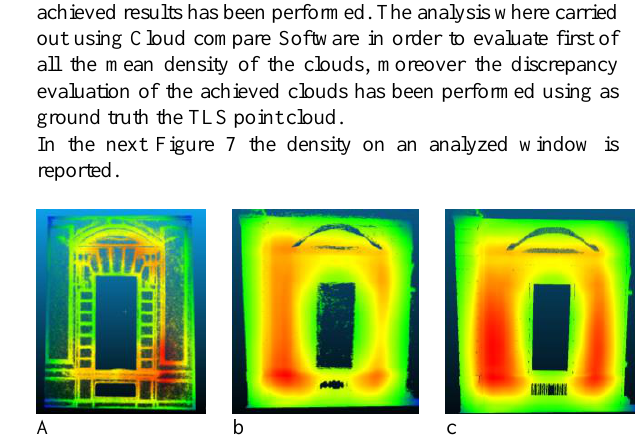
Figure 7. Point cloud density visualization (in red are reported the areas with an higher density) a: ReCap cloud (mean density 19.000 pt sq.m), b:Photoscan cloud (mean density 67.000 pt sq m), c: TLS point cloud (mean density 110.000 pt sqm).